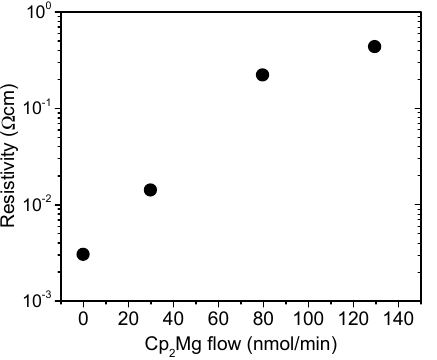
Figure 6. InAlN resistivity TLM method values for different Cp 2 Mg flow.